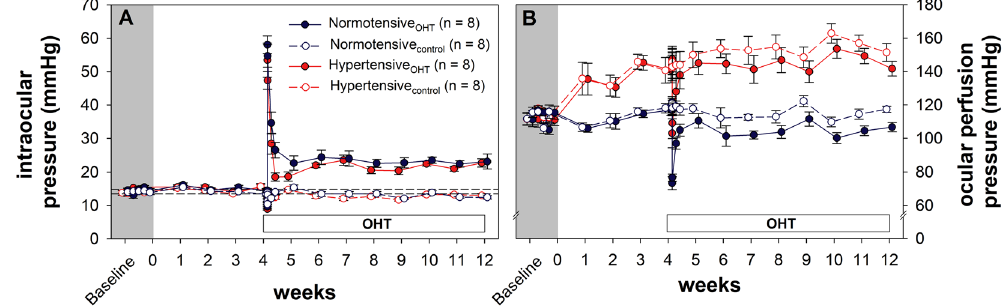
Figure 3. Intraocular pressure profile in animals treated with unilateral circumlimbal suture. ( A ) Effect of circumlimbal suture on IOP (mean ± SEM) in normotensive and hypertensive rats. The broken horizontal reference lines represent the 95% confidence interval of normal IOP derived from baseline measurements across both groups. ( B ) Effect of circumlimbal suture on putative ocular perfusion pressure (mean ± SEM) over 12 weeks in normotensive and hypertensive rats. White bar denotes post circumlimbal suture timepoints. (IOP: intraocular pressure, OHT: ocular hypertension).